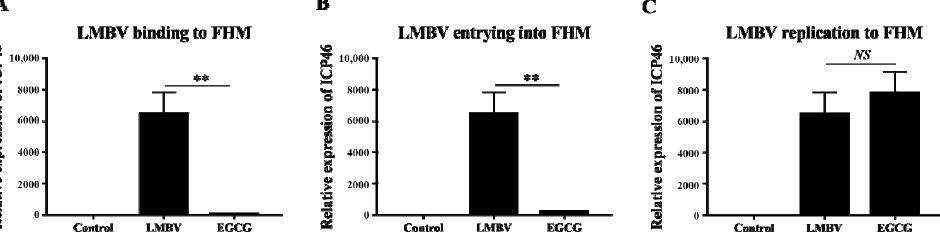
Viruses 2023 , 15 , x FOR PEER REVIEW 8 of 14 Figure 3. Action of EGCG against LMBV particles based on RT ‐ qPCR analysis and light microscopy observations. ( A ) CPEs in FHM cells incubated with purified virus pretreated with EGCG were less abundant than in cells incubated with virus alone. ( B ) The expression level of ICP46 in the EGCG pretreatment group was significantly lower than that in the purified LMBV group without EGCG.